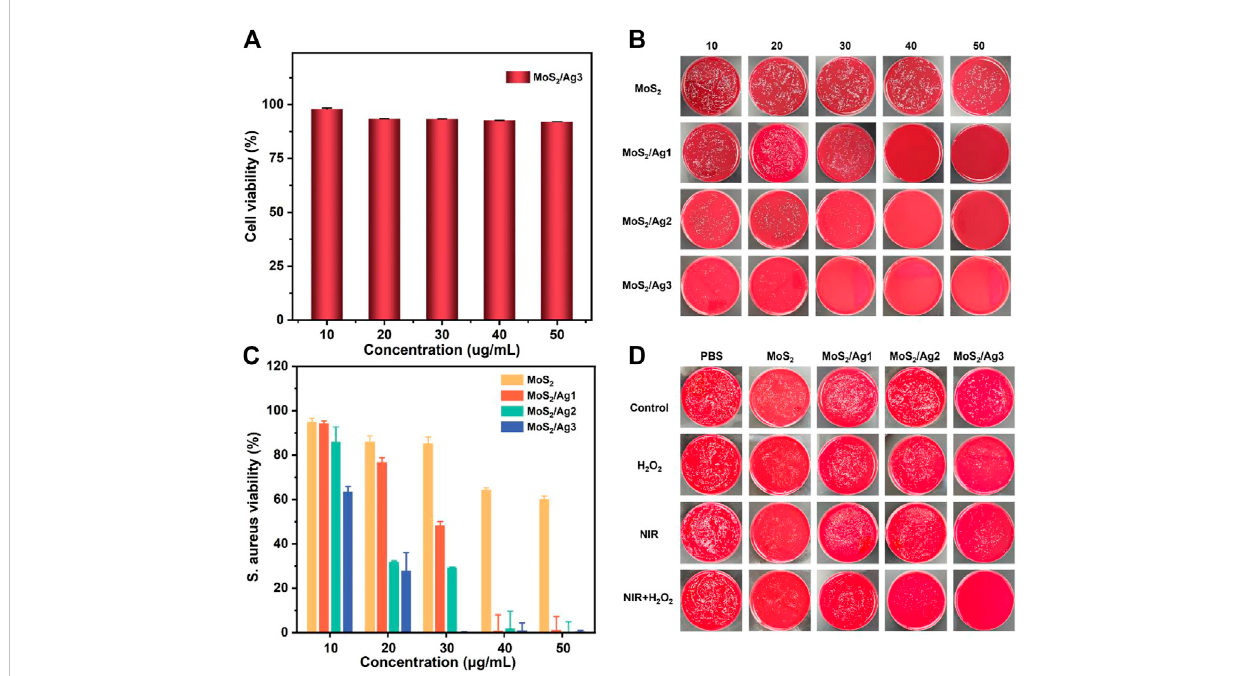
FIGURE 3 (A) Cell viability of L929 cells after treated with MoS 2 /Ag3. (B) S. aureus bacterial colony development after treating with various doses of MoS 2 , MoS 2 /Ag1, MoS 2 /Ag2, and MoS 2 /Ag3,respectively. (C) Bacterial survival rate of S.aureus after treatment with several groups. All groups were treatedwith